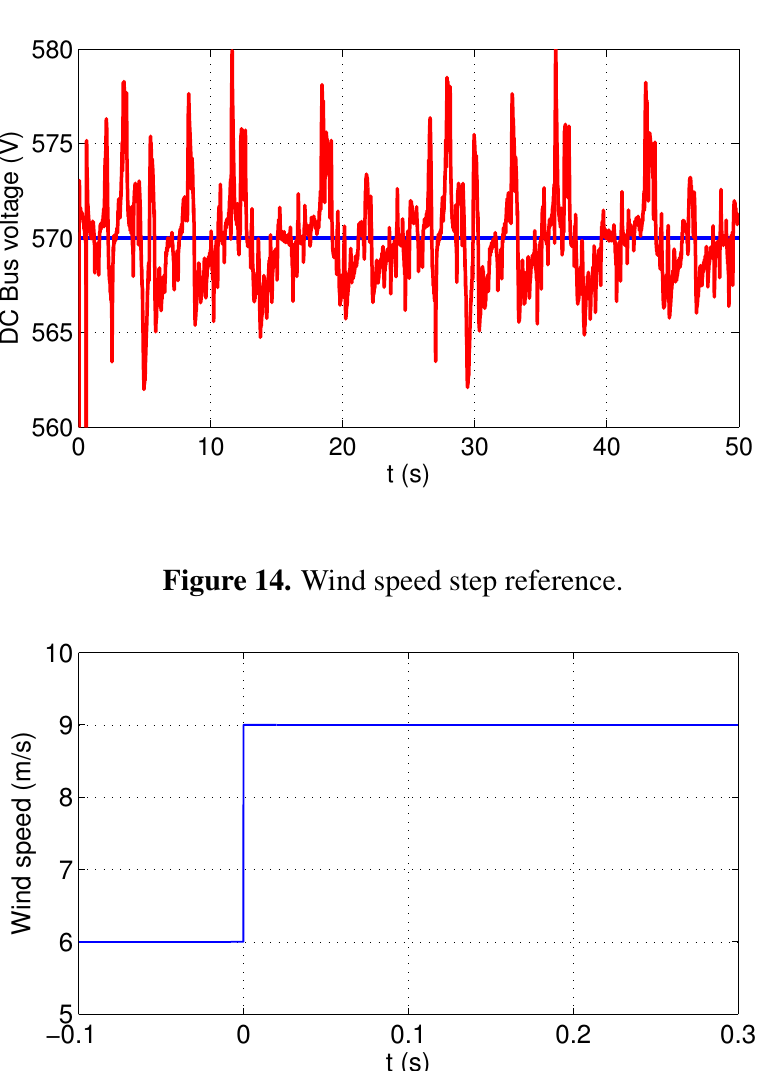
Figure 13. DC link voltage for the wind profile of Figure 5.